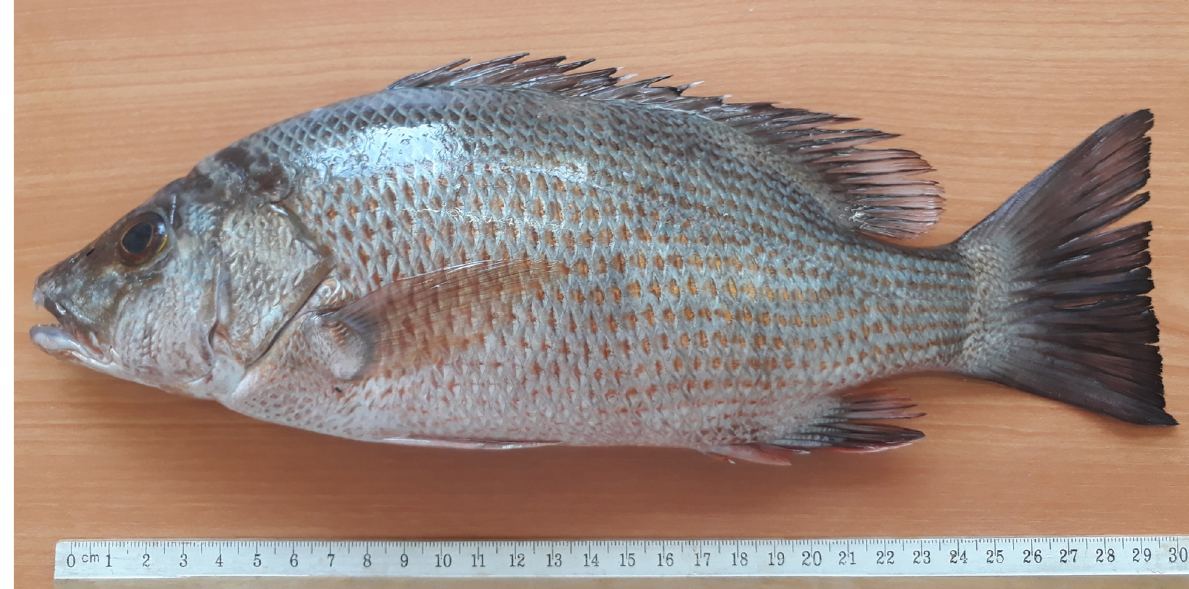
Fig. 1. Mangrove red snapper, Lutjanus argentimaculatus (ref. ESFM-PIS/2018-07), captured from the Gulf of Izmir, Aegean Sea